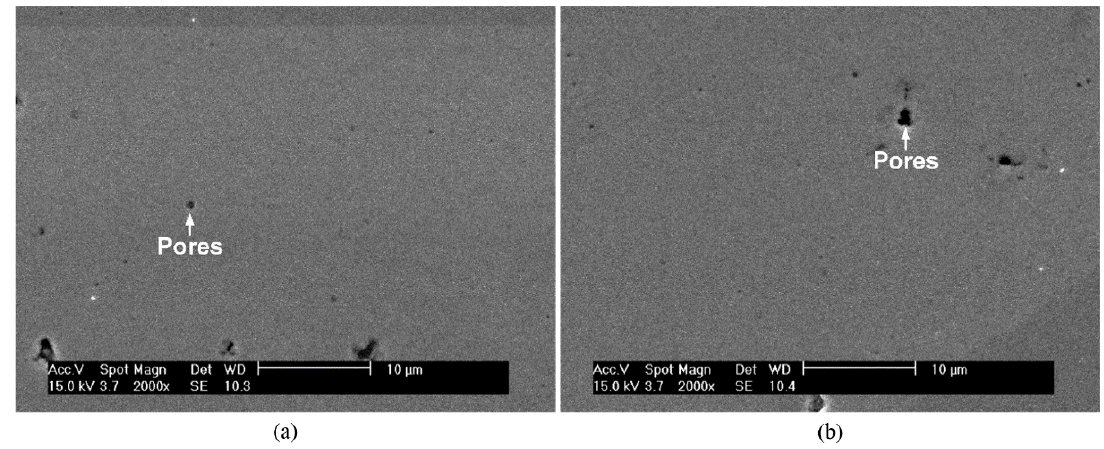
Figure 9. SEM surface micrographs of the samples carburized for 3 hours at 500 °C: (a) 5% CH